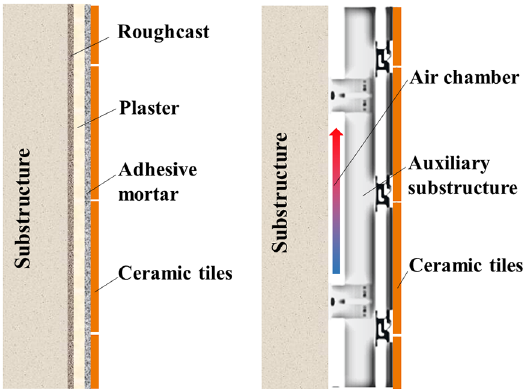
Figure 1. Representation of the models of ventilated facade and adhered